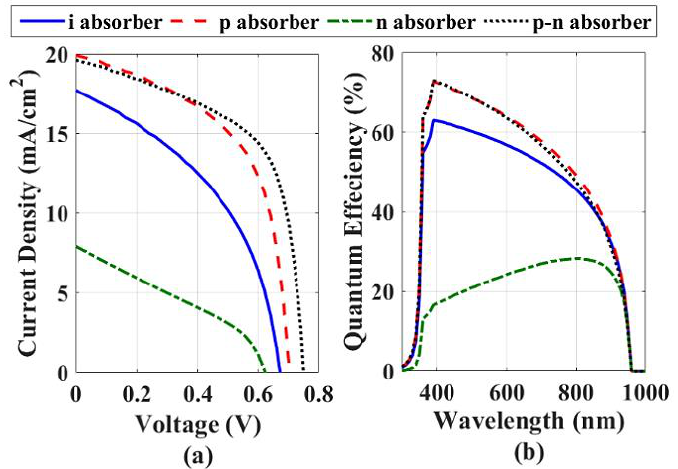
Figure 11. Comparison between different types of absorbers. ( a ) The cell J – V characteristics under illumination, ( b ) quantum efficiency. Table 4. Cell performance parameters of the four studied cases of the absorber layer.